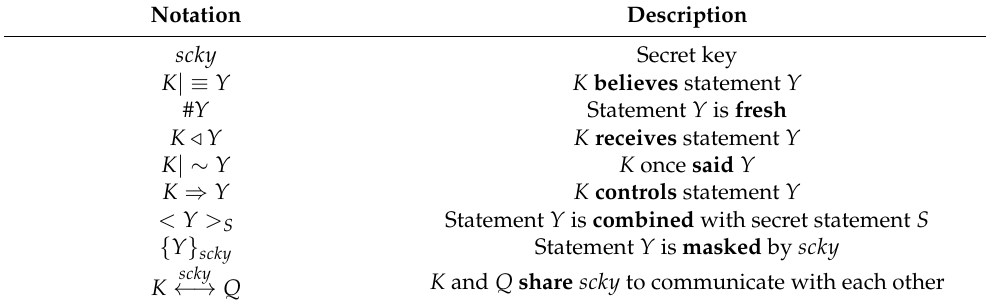
Table 2. BAN Logic